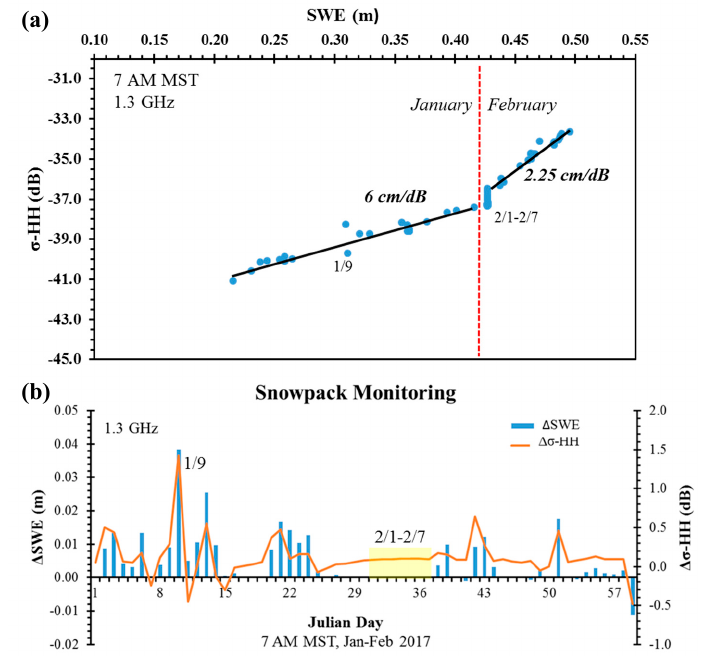
Figure 15. Snowpack monitoring in Grand Mesa at 1.3 GHz HH-pol during the accumulation season, January-February 2017. ( a ) Heuristic linear relationship between snowpack accumulation and backscatter (R 2 > 0.95) reflects the integration of variable weather conditions in January and February in the simulated snowpack. ( b ) SWE and backscatter increments, respectively Δ SWE and Δσ -HH, are calculated as the difference between today’s and yesterday’s values at 7 AM MST. MST- Mountain Standard Time = UTC-7.